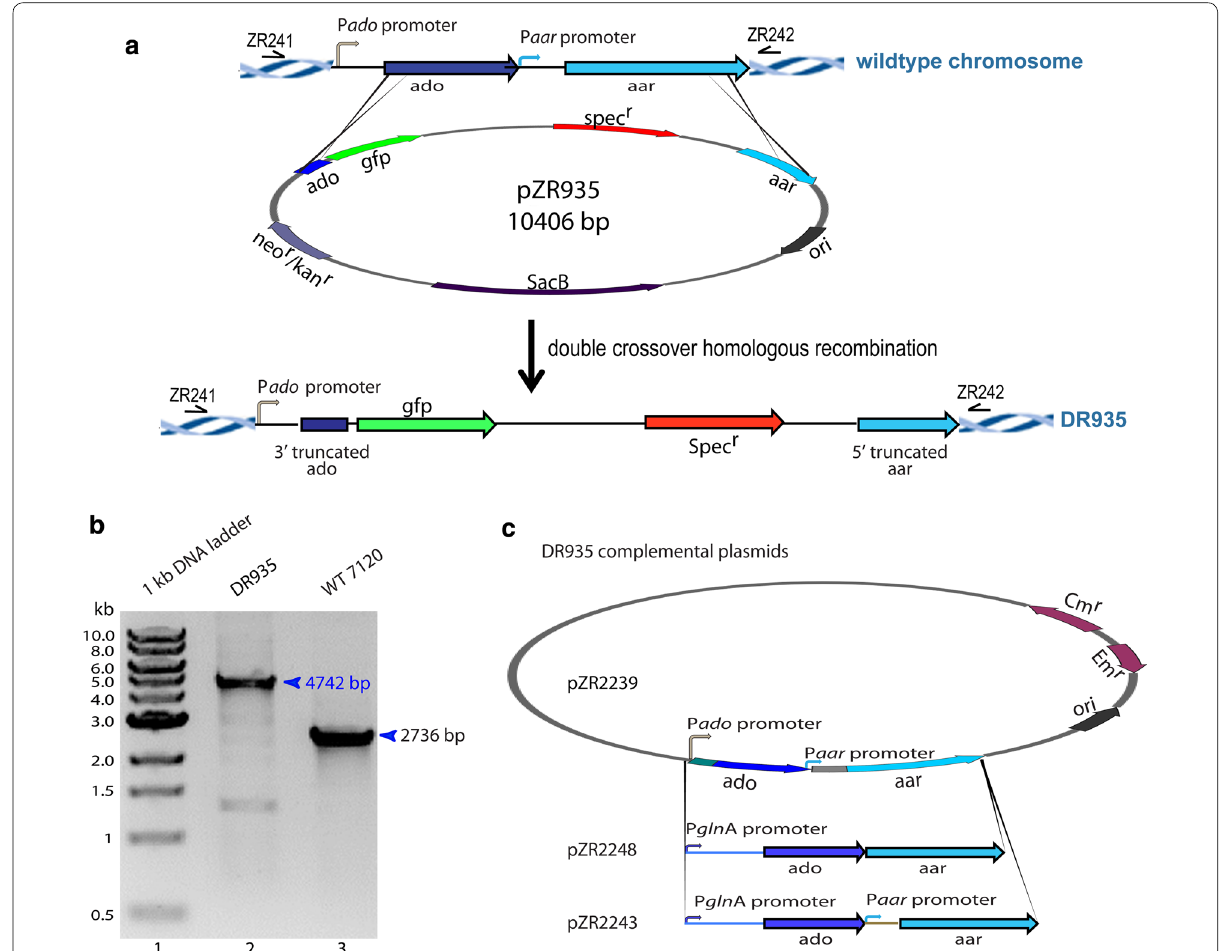
Fig. 3 Construction of Alr5283-Alr5284 knockout mutant (DR935) and its complemented strains in Anabaena 7120. a 3 ′ deletion of ado ( alr5283 ) and 5 ′ deletion of aar ( alr5284 ) created by inserting a gfp - spec cassette between alr5283 – 84 in Anabaena 7120 chromosome via double recombination with knockout plasmid pZR935. b PCR verification of DR935. Wildtype Anabaena 7120 had the intact alr5283 – 84 gene